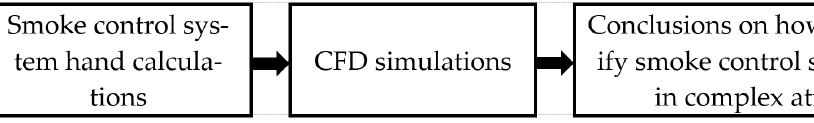
Figure 5. The conducted analysis steps.